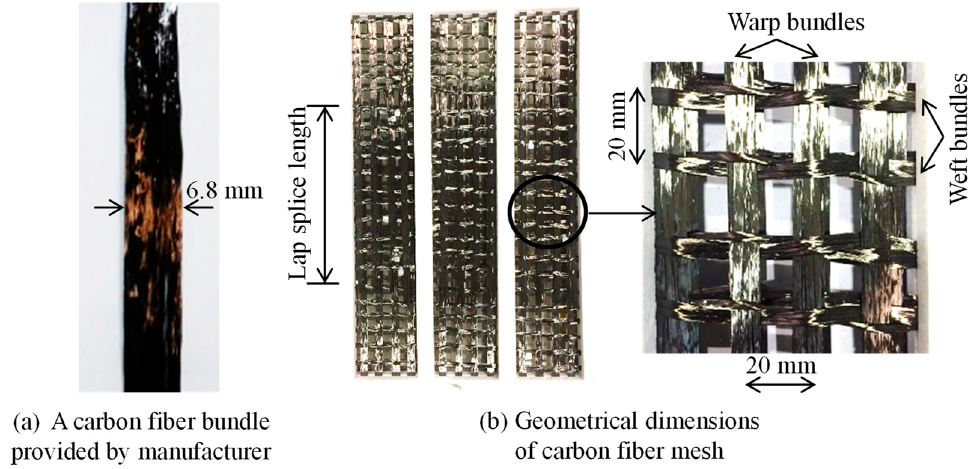
Figure 1. Geometrical properties of carbon fiber mesh used as textile reinforcement.